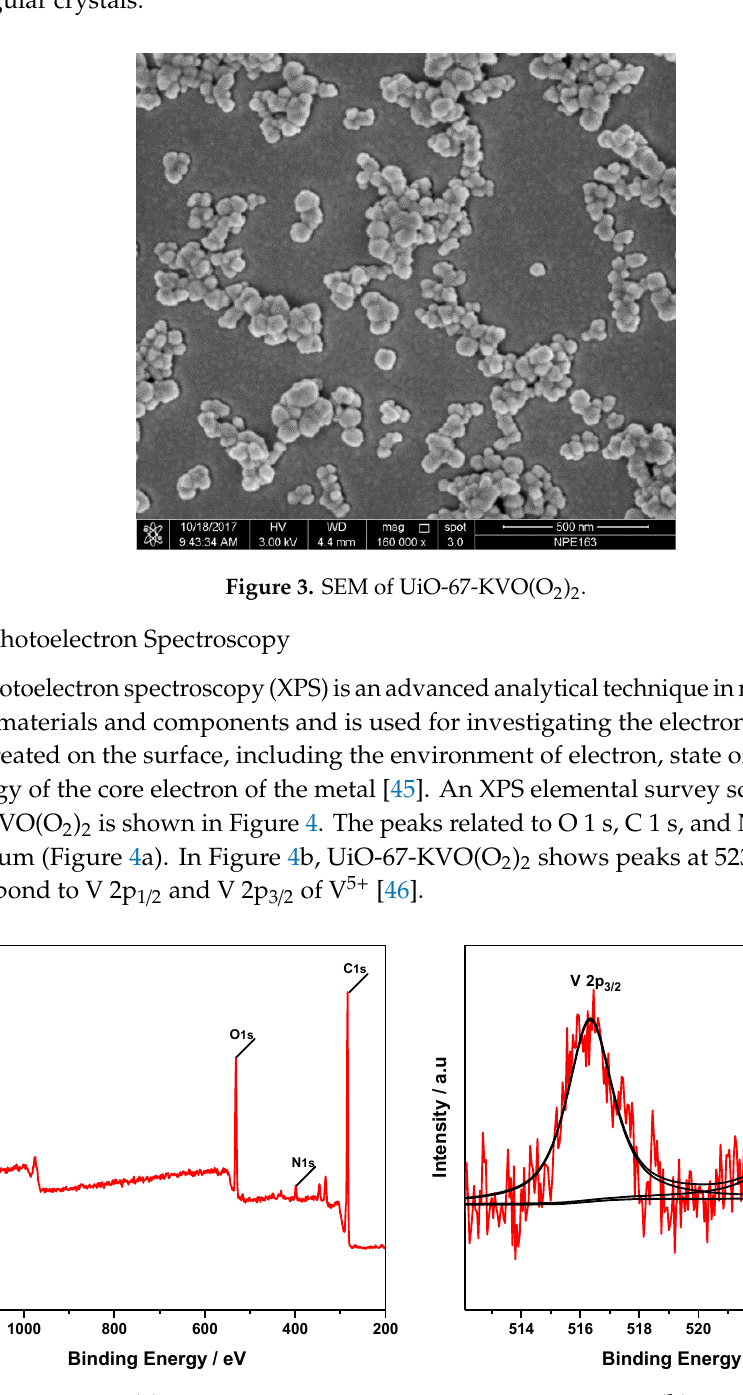
Figure 2. FTIR spectra of UiO-67, UiO-67-MoO(O 2 ) 2 , UiO-67-WO(O 2 ) 2 and UiO-67-KVO(O 2 ) 2 .